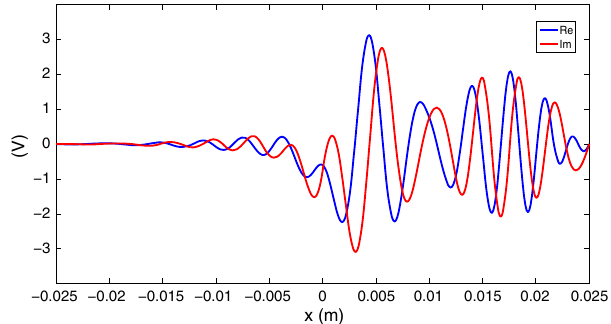
ˆ E k; s; x Þ at y ¼ 0 , at 1 m into sp ð